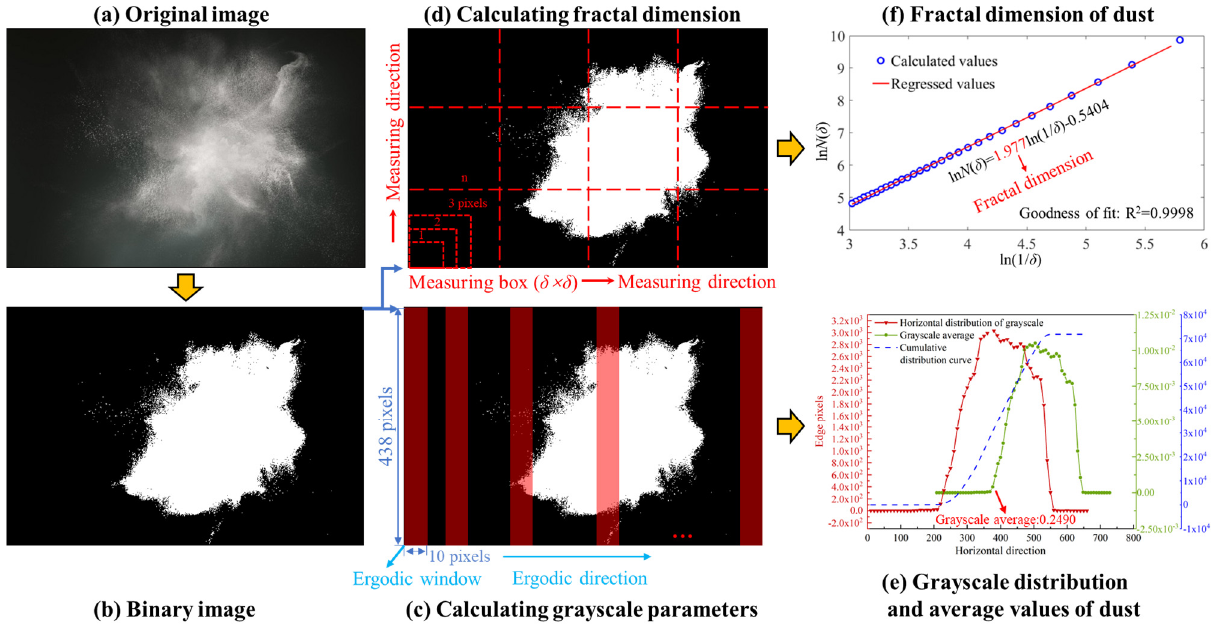
Figure 2. Description of the proposed method for the D box (P) and G a of the fugitive dust picture, including ( a ) original image of fugitive dust, ( b ) binary image through a series of image-processing operations, ( c , d ) calculation process of grayscale properties and D box (P) and ( e , f ) results of grayscale distribution, D box (P) and G a of the fugitive dust.